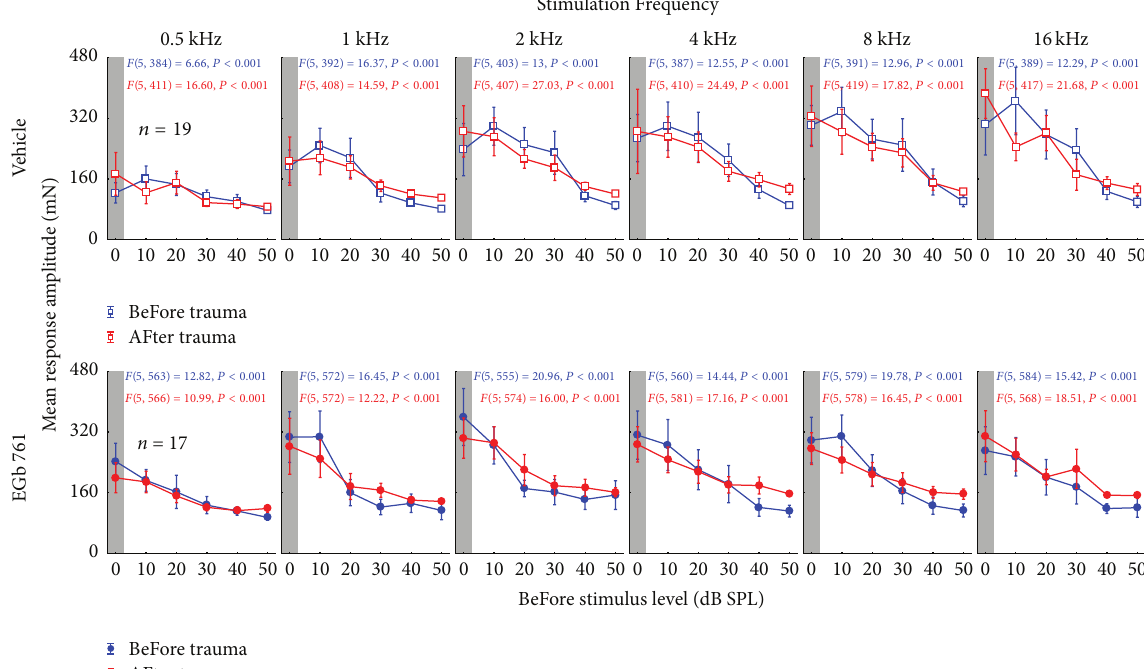
Figure 2: Validation of the hearing threshold ASR paradigm. Given are the mean response amplitudes in mN ( ± 95% confidence interval) for all vehicle treated animals (upper panels) and all EGb 761 treated animals (lower panels) over all prestimulus intensities in dB SPL for the different stimulation frequencies of pre- and startle stimuli. The “pretrauma” (blue) and “posttrauma” (red) data are presented with the corresponding 𝐹 statistics of the 1-factorial ANOVAs. Note that all statistics were significant, demonstrating that the animals were always (pre- and posttrauma = trauma status) responding to the 90dB SPL startle stimulus and the different